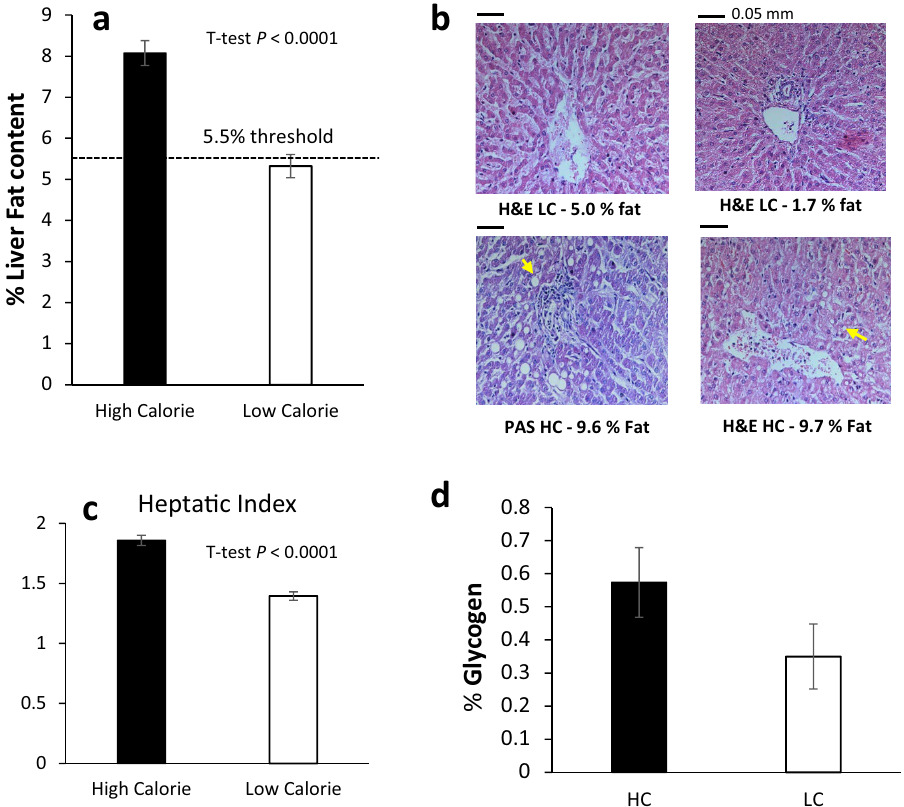
Figure 4. Effect of the high- and low-calorie dietary treatments on the liver. ( a ) Hepatic-fat content, as derived from weight of total fat vs. the wet-liver weight. The HC treatment induced substantial hepatic steatosis, significantly higher than observed for the LC livers (Student t-test, P < 0.0001). ( b ) Representative liver tissue sections from the HC and LC groups analyzed by histopathology with Haematoxylin and Eosin (H&E) or Periodic Acid-Schiff (PAS) staining. The HC hepatocytes (bottom) showed macrovesicular and steatosis around both the portal (left) and central (right) veins. The top LC liver slices showed no lipid droplets formation. The images were taken at a ×200 magnification. ( c ) Hepatic index expressed (liver weight)*100/(body weight). Student’s t-test detects an effect of treatment ( P < 0.0001). ( d ) Percentage of liver glycogen. The values in the HC group trended higher than in the LC group, though not significantly different (student’s t-test, P < 0.1308; SEM = 0.0735).